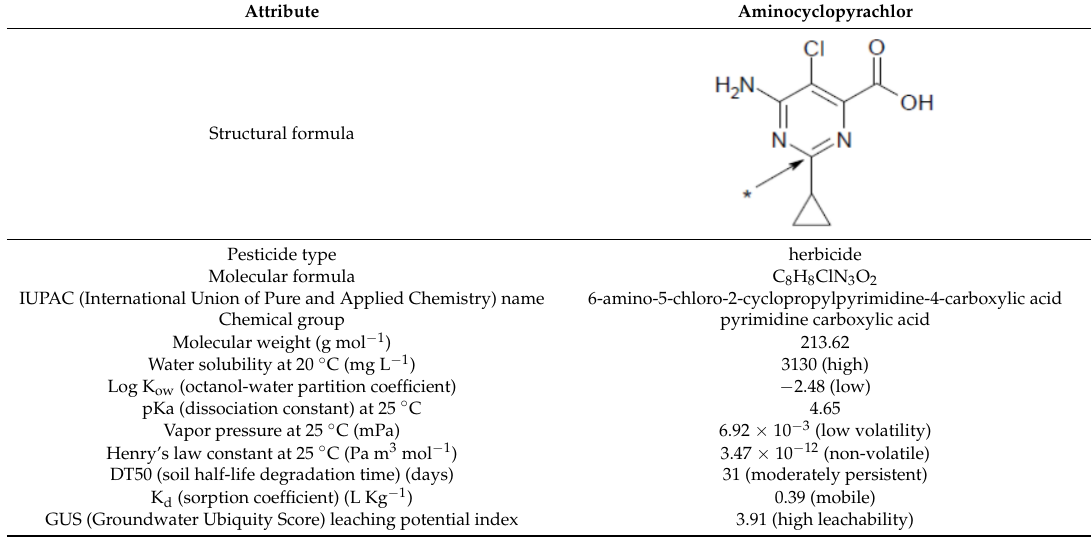
Table 1. Structural formula and physico-chemical properties of aminocyclopyrachlor.